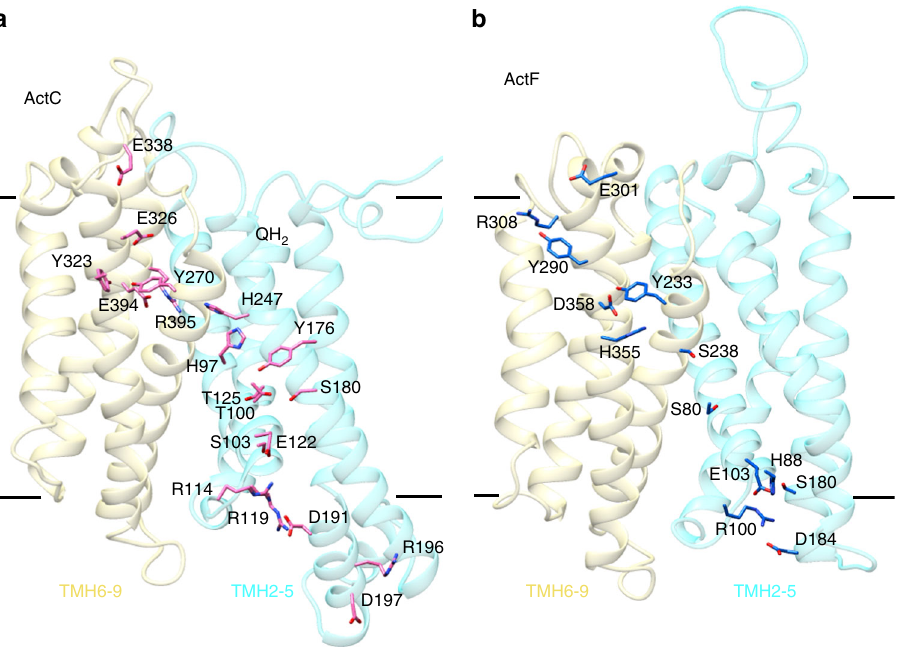
Fig. 6 Proton pathways. a ActC proton-conducting half-channels. The cytoplasmic half-channel (TMHs 2 – 5) consists of residues Asp197, Arg196, Asp191, Arg119, Glu450, Arg114, Glu122, Ser103, Thr100, Thr125, Ser180, Tyr176, His97, and His247. The periplasmic half-channel (TMHs 6 – 9) includes residues Arg395, Glu394, Tyr270, Tyr323, Glu326, and Glu338. The approximate position of the quinol pocket is indicated (QH 2 ). b ActF proton-conducting half- channels. Cytoplasmic (TMHs 2 – 5) and periplasmic (TMHs 6 – 9) proton-conducting half-channels of ActF include residues Asp184, Arg100, Ser180, Glu103, His88, Ser80, Ser238, His355, Asp358, Tyr233, Tyr290, Arg308, and Glu301. The four-helix bundles are shown in light blue (TMHs 2 – 5) and yellow (TMHs 6 – 9). Note that density for aspartate and glutamate residues is not visible and their side chains have been modeled